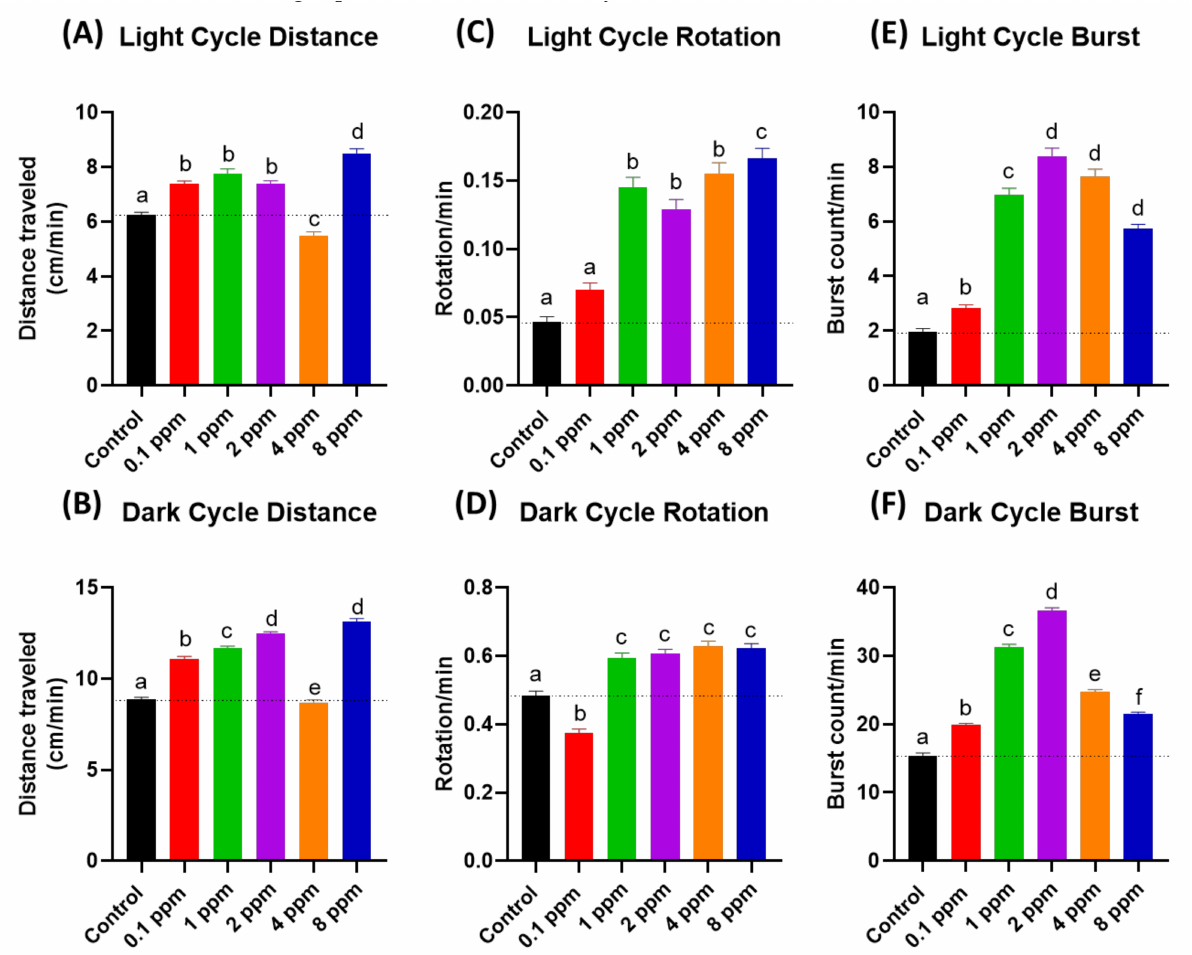
Figure 1. The RAC effect on zebrafish photomotor activities. ( A ) Total distance traveled of zebrafish larvae after 24-h incubation to different doses of RAC in ( A ) light cycle and ( B ) dark cycle. Total rotation movement of zebrafish larvae after 24-h incubation to different doses of RAC in ( C ) light cycle and ( D ) dark cycle. Total burst movement of zebrafish larvae after exposed to different doses of RAC for 24 h in ( E ) light cycle and ( F ) dark cycle. The data were shown as the Mean ± SEM and analyzed by Kruskal–Wallis test followed with Dunn’s multiple comparisons test. Different letters a, b, c, d, e, and f above columns indicate significant statistical differences with p < 0.05 ( n = 96 for all groups). Black bar: control, red bar: RAC 0.1 ppm, green bar: RAC 1 ppm, purple bar: RAC 2 ppm, orange bar: RAC 4 ppm, and blue bar: RAC 8